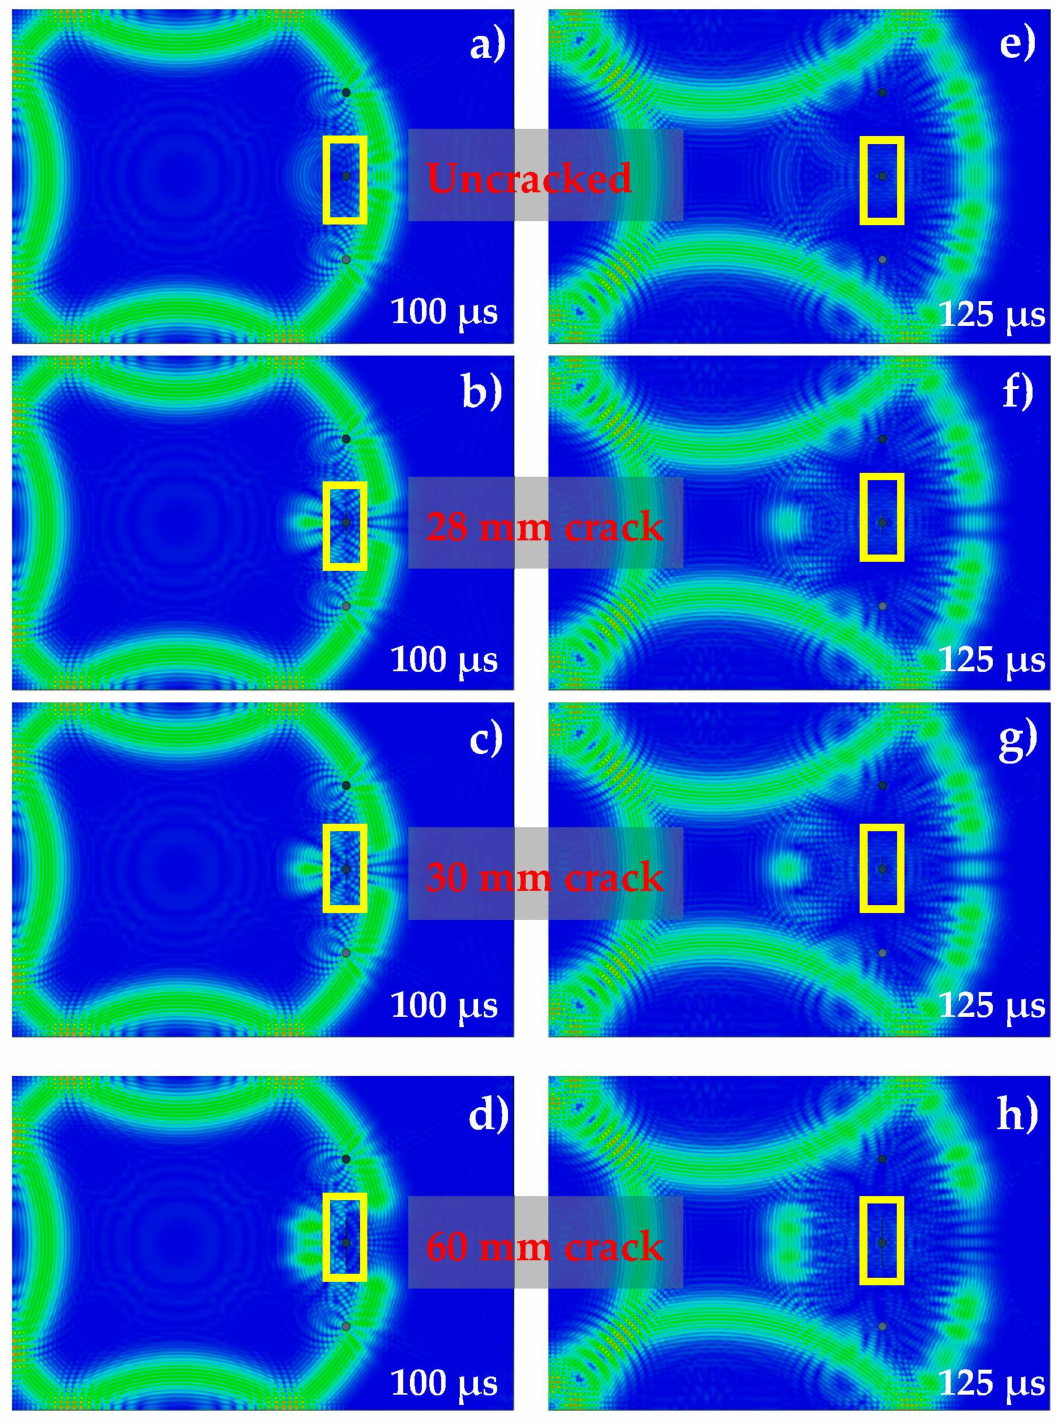
Figure 3. ( a – h ) Lamb wave propagation at t = 100 and 125 µ s in Al 7075 Plate with different crack